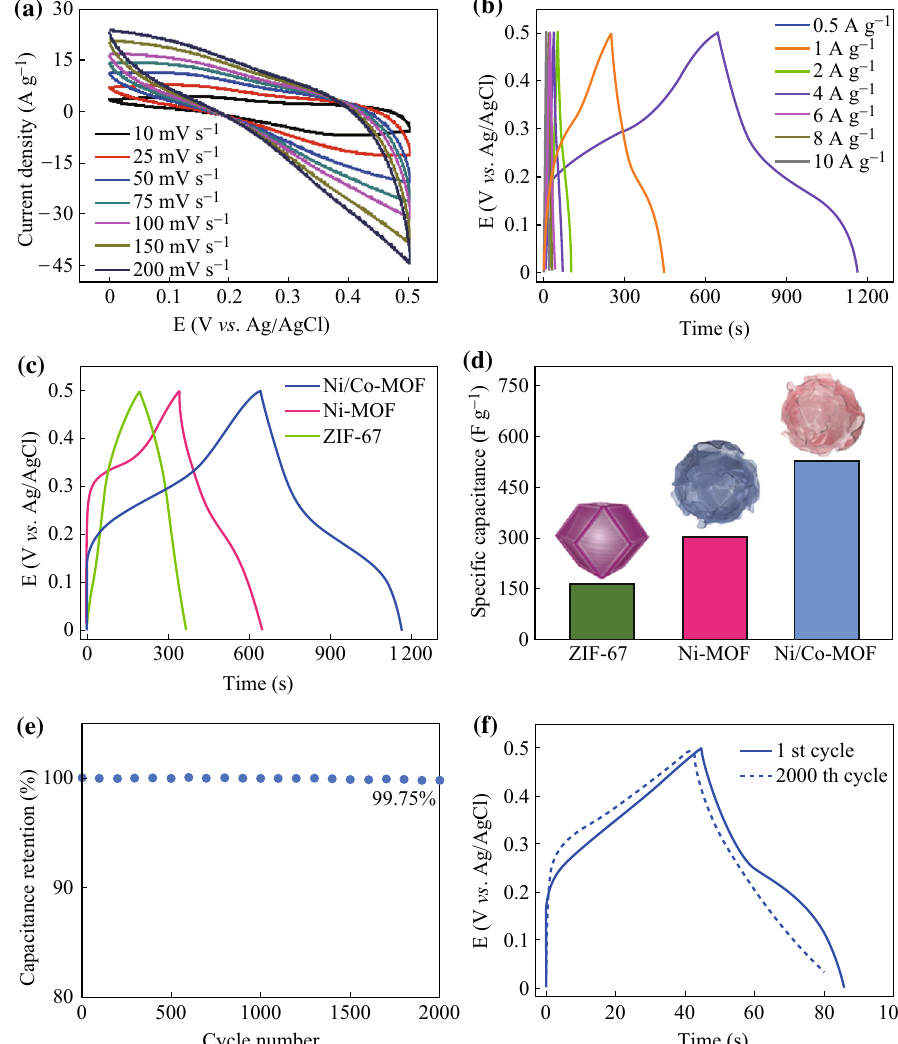
Fig. 3 a Cyclic voltammograms of as-prepared Ni/Co-MOF nanoflake electrodes at different scan rates in 1 M LiOH solution. b Galvanostatic charge–discharge curves of Ni/Co-MOF nanoflakes at various currents in 1 M LiOH solution. c Galvanostatic charge–discharge curves comparison of Ni/Co-MOF nanoflakes, ZIF-67, and Ni/Co-MOF nanoflakes at various current densities in 1 M LiOH solution. d Specific capacitances of Ni/Co-MOF nanoflakes, Ni-MOF nanoflakes, and ZIF-67 electrodes at 0.5 A g - 1 . e Cycling performance of Ni/Co-MOF nanoflakes at a current density of 2 A g - 1 . f Galvanostatic charge–discharge curves of Ni/Co-MOF nanoflake supercapacitor before and after 2000 cycles measured at 2 A g -